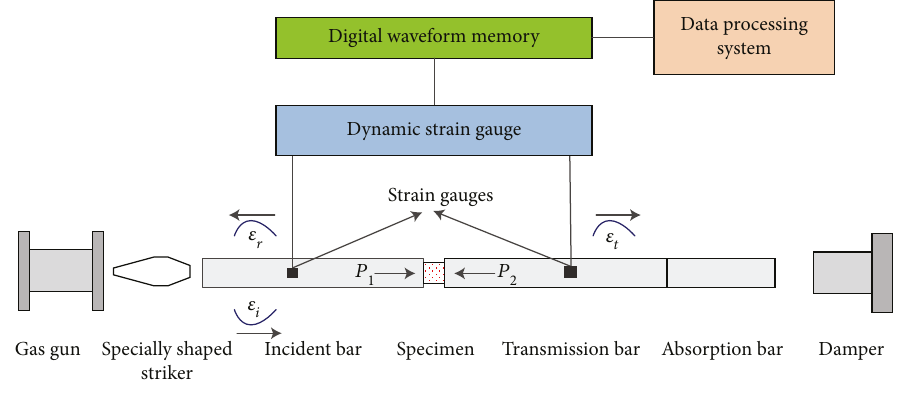
Figure 2: The SHPB test